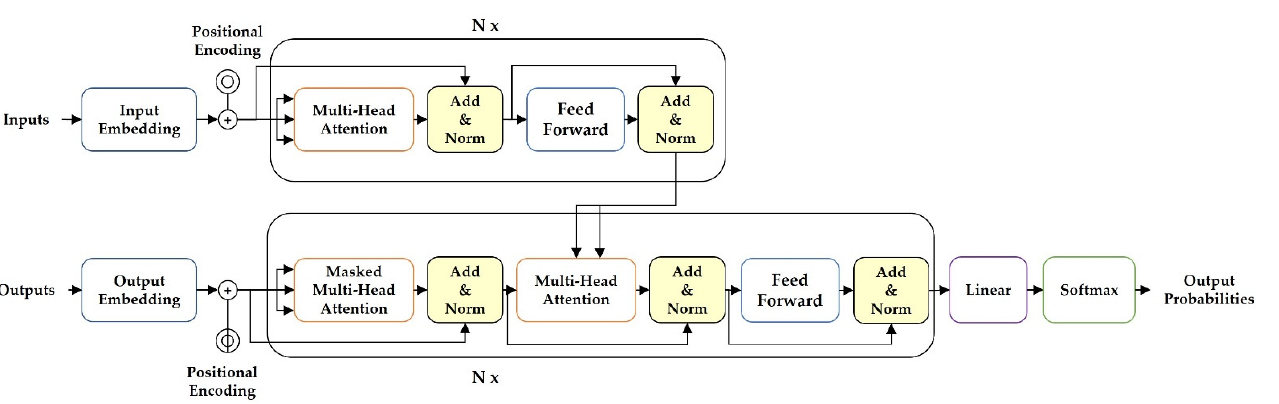
Figure 4. Overview of the proposed web interface of NER and RE with BERT.